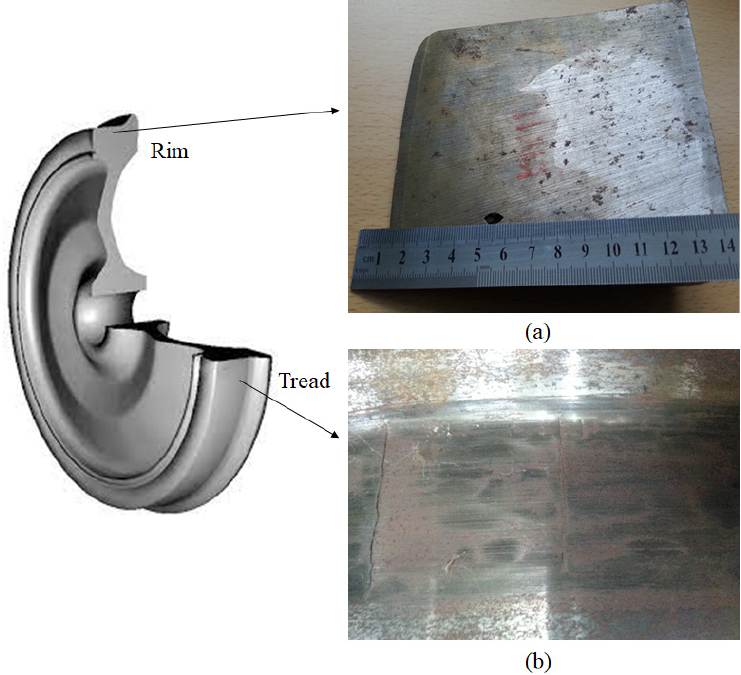
Figure 2. Defects in railway wheels: ( a ) subsurface crack; ( b ) surface